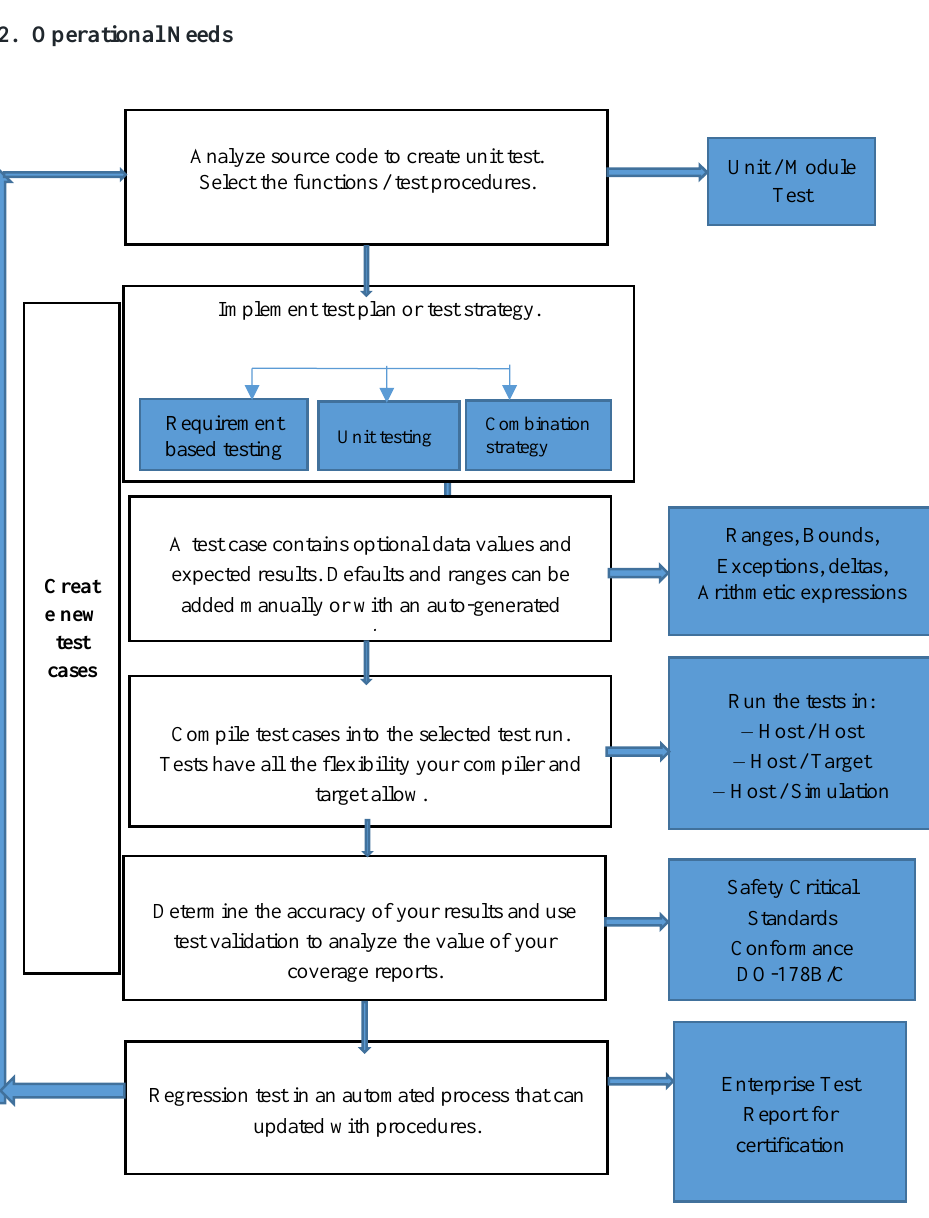
Fig. 2. Code Test